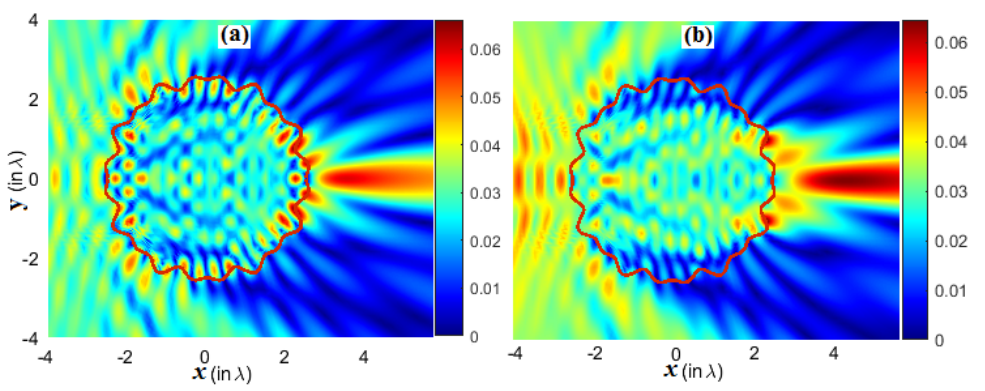
Figure 7. Illumination by a point-source for a cylinder with n = 1.452, ( m 1 , m 2 ) = (16,4), and β = 0.178 placed at: ( a ) d = 7 λ , and ( b ) d = 5 λ . (The colormap denotes the total field